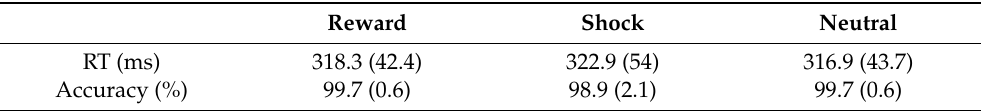
Table 3. Mean RT and accuracy for each target type in the training phase of Experiment 2. Numbers in parentheses represent the standard